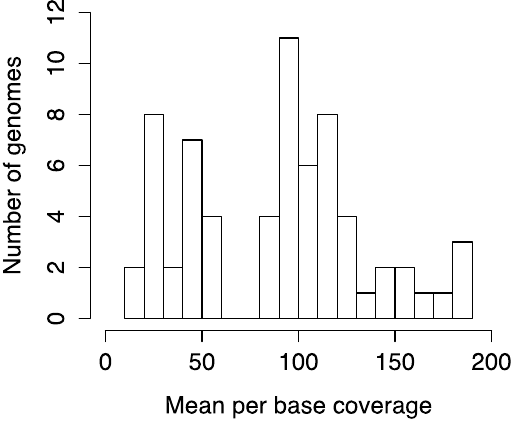
Figure 1. Sequencing depth of newly sequenced haloarchaeal genomes. Histogram showing distribution of mean per base coverage for the 59 newly-sequenced and seven previously published draft genomes [109] included in this